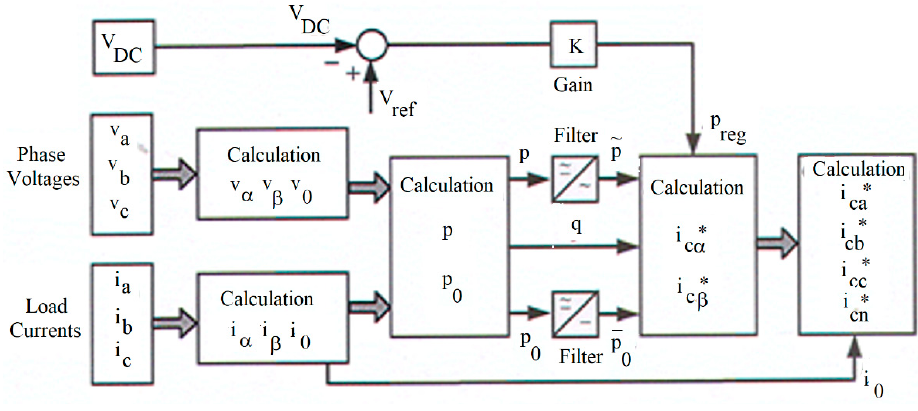
Figure 4. Calculations for the constant instantaneous supply power control strategy [30].